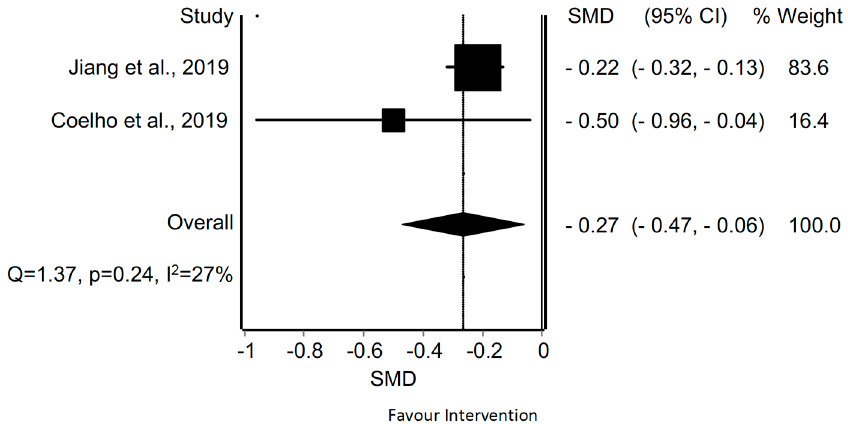
Figure 12. Synthesis forest plot for disability in patients with tension-type headache treated with manual therapy. The forest plot summarizes the results of included studies (review size, standardized mean differences [SMDs] and weight). The small boxes with the squares represent the point estimate of the effect size and sample size. The lines on either side of the box represent a 95% confidence interval (CI).